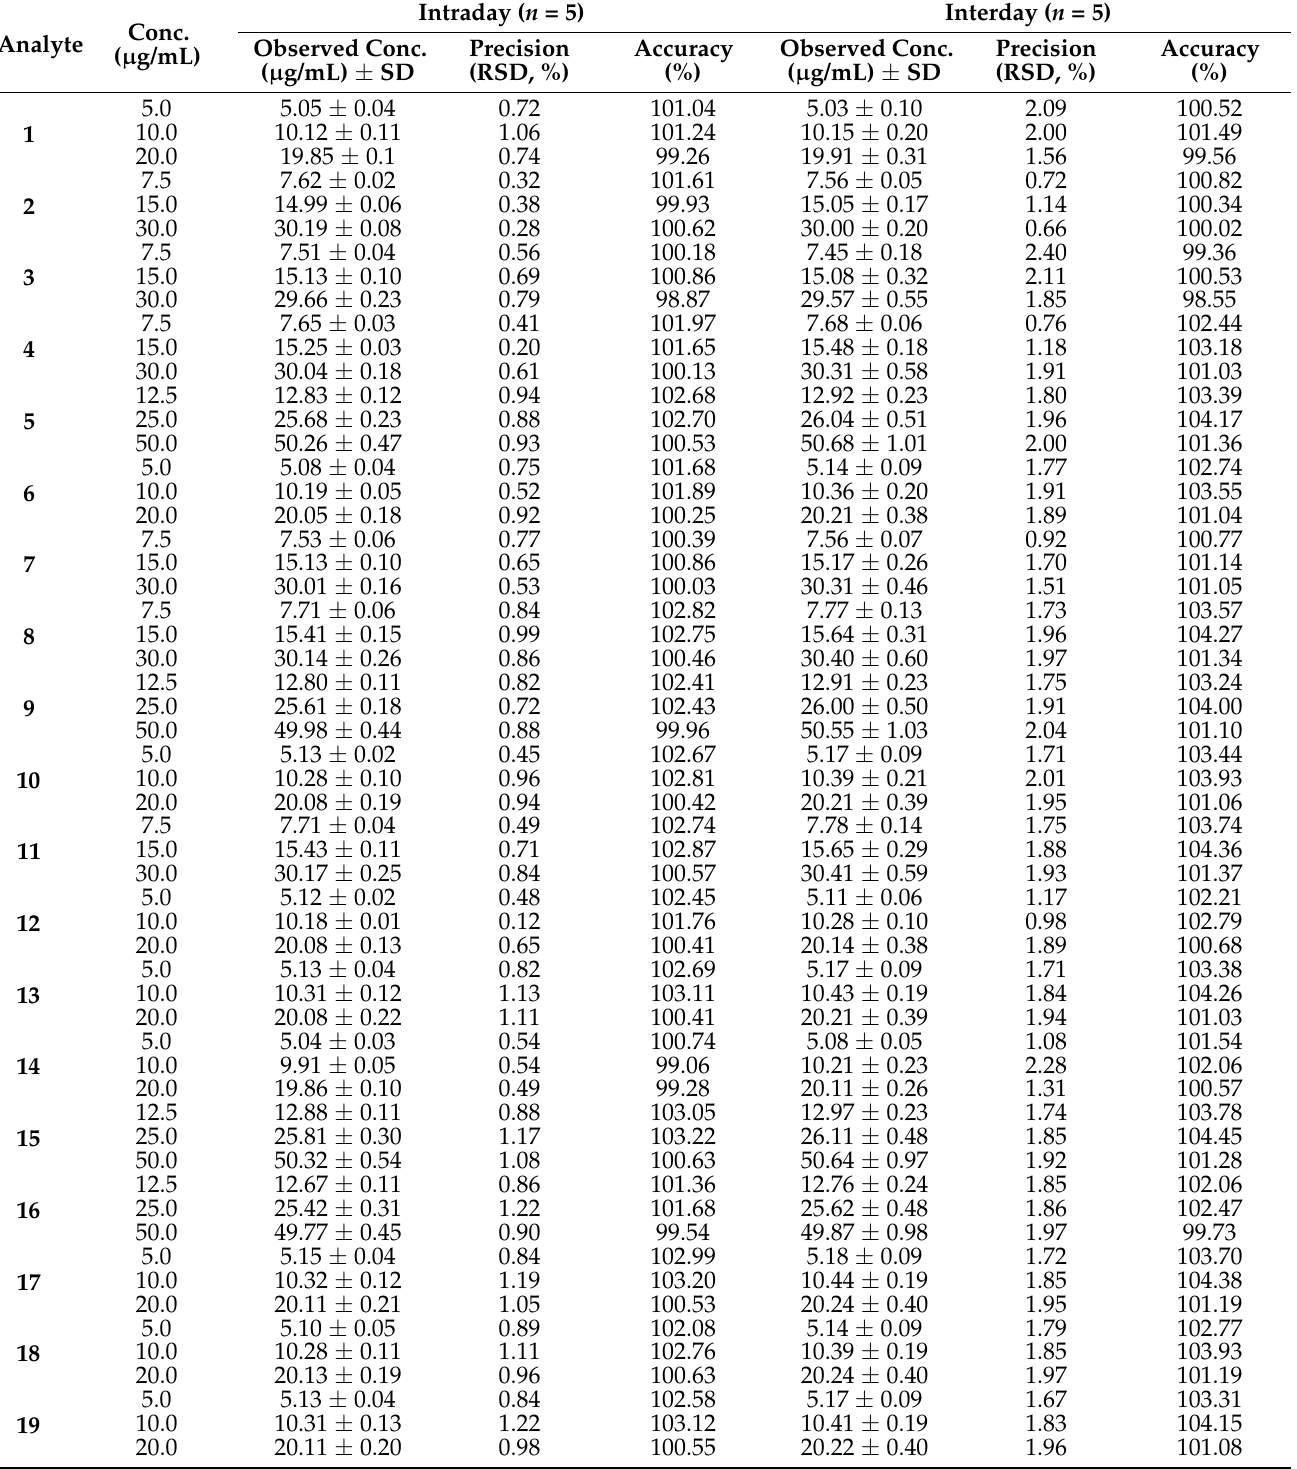
Table 3. Precision test of marker compounds 1 – 19 in the developed HPLC